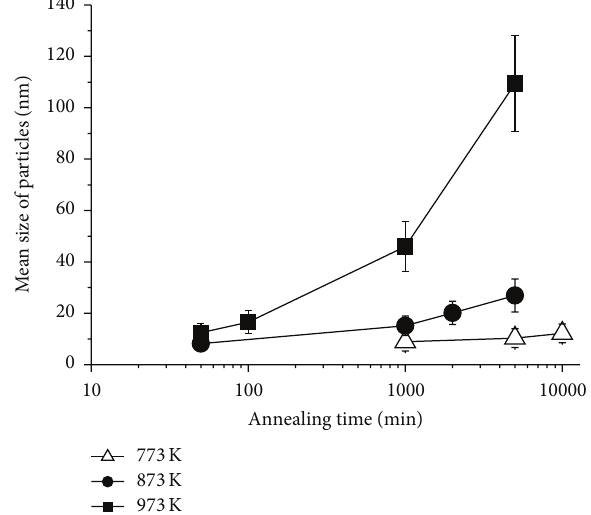
Figure 2: Mean size of precipitates of Cu-1.8at%Fe-1.2at%Co annealed at 773 K, 873 K, and 973